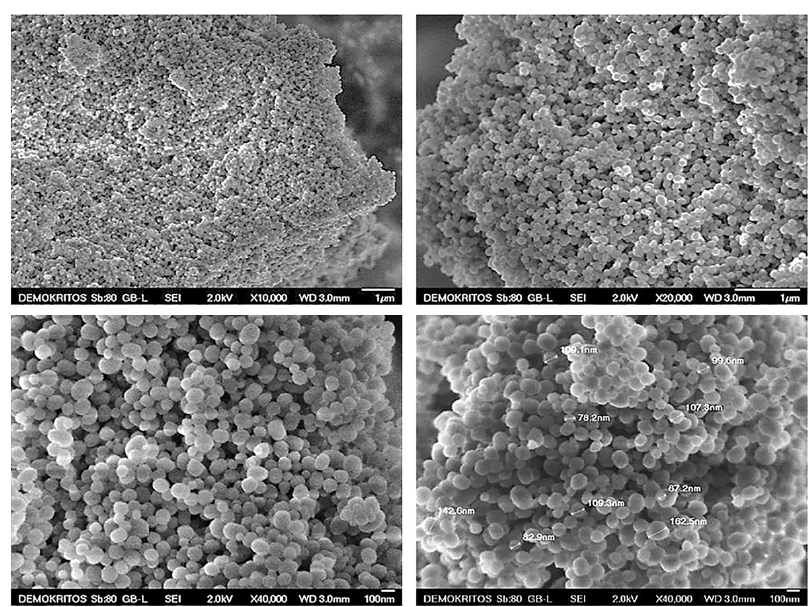
Figure 2. SEM micrographs of the produced MCM-41 particles.